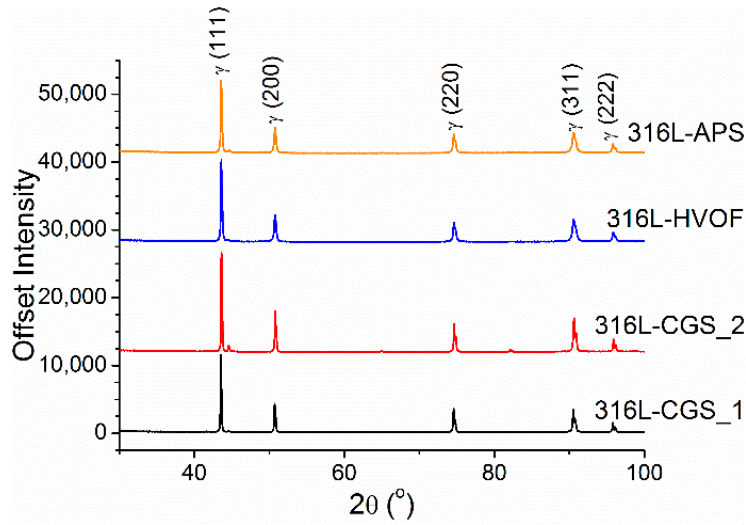
Figure 3. XRD patterns of the 316L feedstock powders.